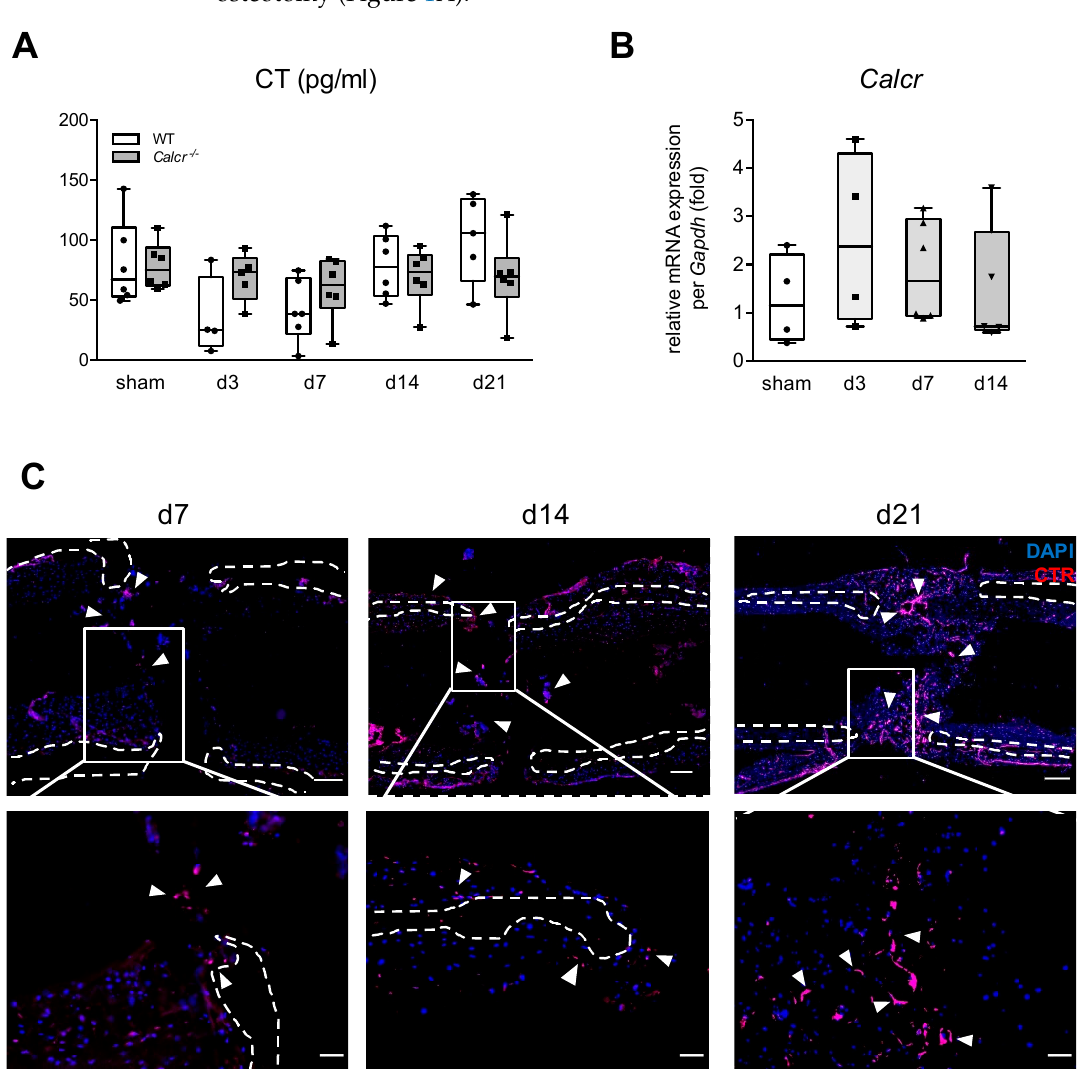
Figure 1. CTR is expressed in the fracture callus. ( A ) Serum CT levels in WT and CTR-deficient mice with an osteotomy and stabilized with an external fixator 3, 7, 14, and 21 days post-injury. ( B ) Gene expression of CTR ( Calcr ) in the fracture callus at the respective time points during bone regeneration. ( C ) Representative immunofluorescent images (merged) of WT callus sections 7, 14, and 21 days after surgery using a specific antibody for CTR. Dotted lines indicate cortices and arrows indicate CTR positive structures. Scale bars = 200 µm (top) and 50 µm (bottom), respectively. For ( A , B ) n = 4–6 mice per group and time point as indicated. Box plots represent median with minimum and maximum whiskers.